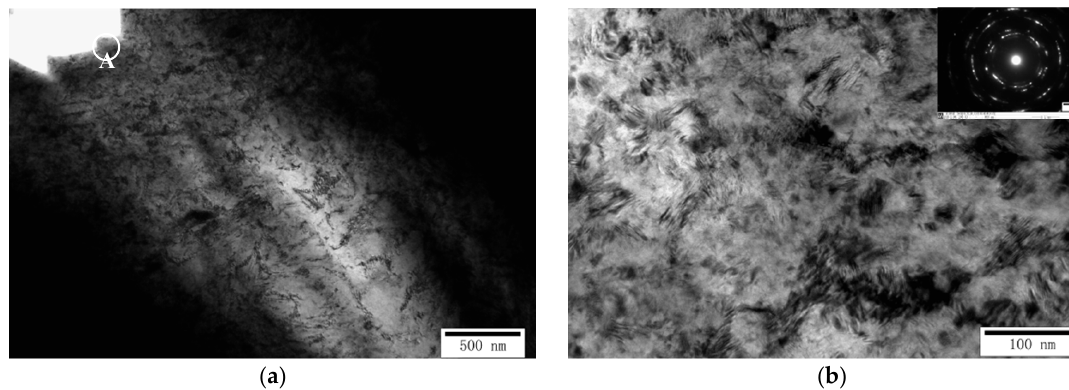
Figure 10. Transmission electron microscope (TEM) image and selected area electron diffraction (SAED) pattern of the blanked edge and adjacent deformation zone (SPM 1200). ( a ) TEM image of the vertical blanked edge (I); ( b ) TEM image and SAED pattern of the selected area.